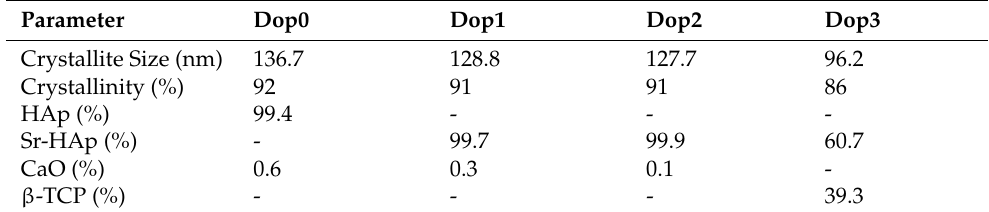
Table 3. Crystallite size (nm) and crystallinity (%) for HAp samples under investigation.